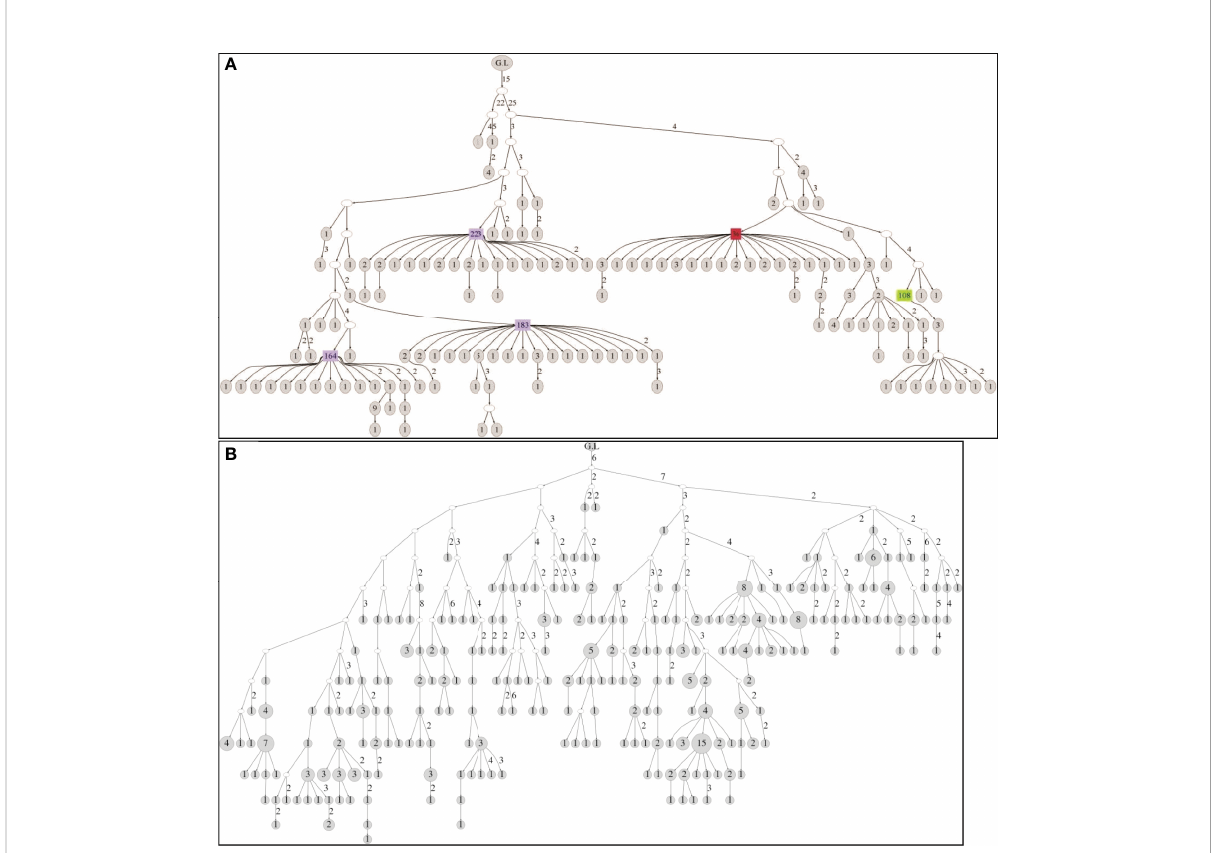
FIGURE 4 (A) Tree structure of a clone obtained from the biopsy of the 25-year-old patient. The clone contains 246 unique sequences and 650 sequences in total. (B) Tree structure of a clone obtained from the biopsy of the 89-year-old patient. The clone contains 331 unique sequences and 370 sequences in total. In both fi gures, G.L signi fi es the location of the root (germ line). The numbers near edges mean the distance in number of point mutations between the nodes linked. The total number of sequences represented by each node is noted inside the node, with large numbers highlighted in